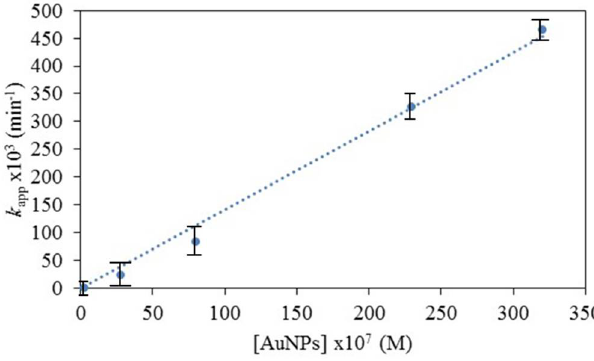
Figure 8. Plot of apparent rate constant k app versus concentration of AuNPs (data from Table 1).